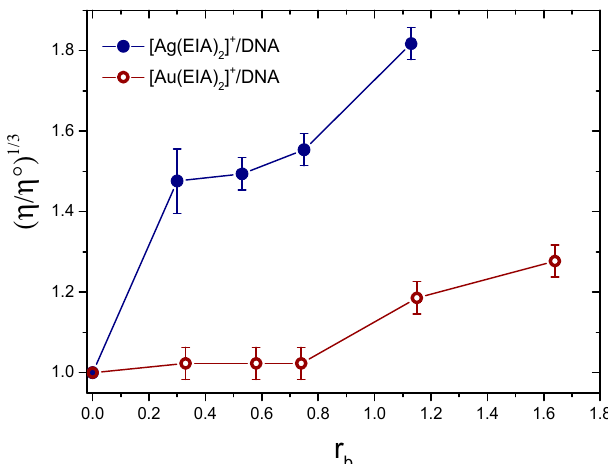
Figure 5. Relative viscosity of DNA mixtures with [Ag(EIA) 2 ] + or [Au(EIA) 2 ] + , r b = [complex]/[DNA], C DNA = 2.10 × 10 − 5 M, NaCl 0.1 M, 2.5 mM NaCac, pH = 7.0, T = 25.0 °C.